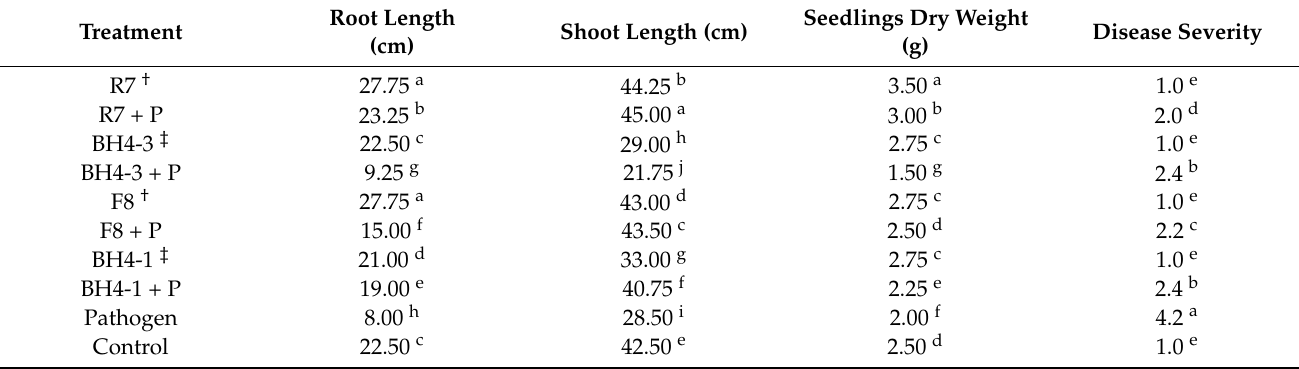
Table 3. Effect of four actinomycetes isolates on tomato seedlings cv. Superchief growth parameters and disease severity. Growth parameters and disease severity were measured simultaneously when seedlings were uprooted and washed; their dry weights were measured after 48h incubation at 60 ◦ C.